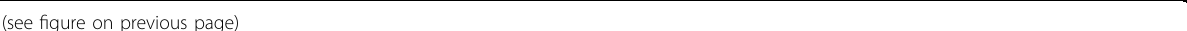
Fig. 3 H19 attenuates PA-induced mitophagy enhancement in H9c2 cells. A – D Effects of PA and H19 on mitochondrial turnover assessed by mitoTimer. The initial state of this protein is green, which could shift to red over time if mitochondria were not eliminated. Scale bar: 100 μ m. E and F Effects of PA and H19 on the co-localization of mitochondrial marker (TOM20) and autophagosomes ( E , LC3B-II)/autolysosomes ( F , LAMP1) assessed by immuno fl uorescence staining. Yellow dots indicated co-localization of LC3B-II or LAMP1 and TOM20. PA treatment increased the number of yellow dots, and this trend was abolished upon treatment with H19. Scale bar: 10 μ m. G , H Statistical analysis of yellow puncta numbers in ( E ) and ( F ), n = 4. I Green dots represent the initial state of mtKeima proteins or mitochondria, and red dots (some could be yellow) indicate mtKeima or mitochondria in lysosomes. A relatively increased ratio of red intensity area to total intensity area (red and green) suggested enhanced mitophagy. Scale bar: 10 μ m. J Ratio of red intensity area to total intensity area (red and green) of mtKeima in I , n = 4. K The TEM images show normal mitochondria or mitophagy in H9c2 cells with different treatments. Green arrows represent normal mitochondria, and red arrows indicate mitochondria in autophagosomes or autolysosomes. The zoomed-in images show high-magni fi cation views of the outlined areas Scale bar: 2 μ m. L Statistical analysis of the number of mitochondria in autophagosomes or autolysosomes among the four groups, n = 4. M and N Effects of PA, H19 and bafA1 (autophagy inhibitor) on mitochondrial number assessed by mtDNA copy number (detected by PCR) and MitoTracker ™ Green dye staining (detected by fl ow cytometry). Data in B , G , H , J , L , M , and N are expressed as mean ± SEM. All the statistical analyses were performed base on four randomly selected scopes under observed by confocal microscope ( A – J ) or TEM ( K , L ). * P < 0.05; ** P < 0.01; *** P < 0.001. BSA, bovine serum albumin; PA, palmitic acid; H19, H19 overexpression; Vector, control lentivirus of H19; LC3B-II, light chain 3, mark of autophagosomes; TOM20, translocase of the outer membrane 20, mark of mitochondria; LAMP1, lysosome-associated membrane protein 1, mark of lysosomes; mtDNA, mitochondrial DNA; BafA1, ba fi lomycin